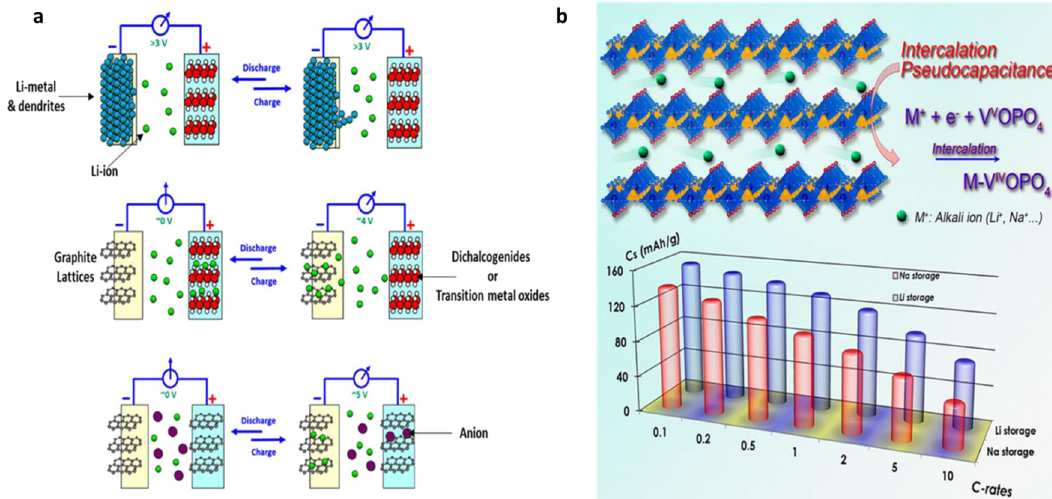
Fig. 3 Intercalation for energy storage applications. a Typical battery con fi gurations for Li-ion batteries 95 . (top) half-cell where only the cathode serves as intercalation host. (middle) Both electrodes serving as hosts (typical Li-ion battery con fi guration) (bottom) “ dual-ion intercalation ” in which both anions and cations serve as intercalants and both electrodes serve as hosts (Read et al.) 96 . b Pseudocapacitance of VOPO 4 with Li + and Na + intercalation 130 . Panel a adapted with permission from ref. 95 Chem. Rev. 118 , 11433 – 11456 (2018) Copyright (2018). American Chemical Society; Panel b adapted with permission from ref. 130 Nano. Lett. 16 , 742 – 747 (2016). Copyright (2016). American Chemical